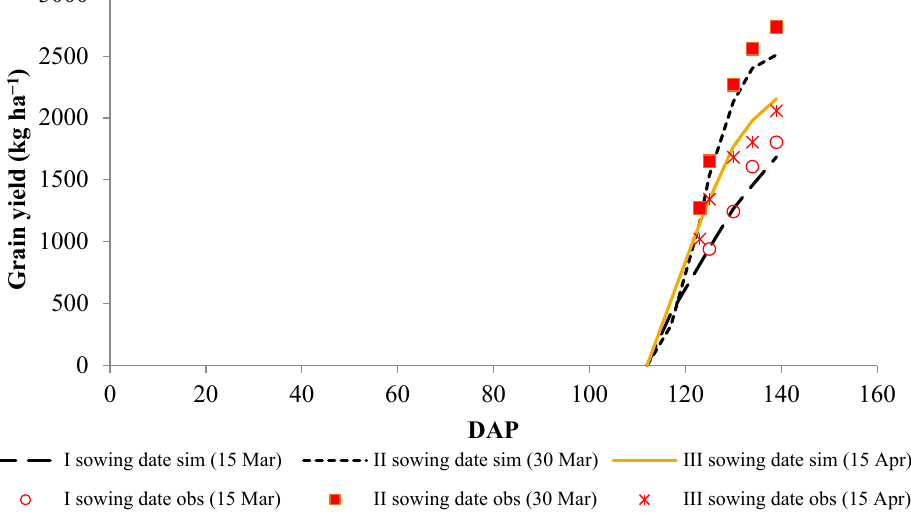
Dingxi in 2020 from sowing to maturity.